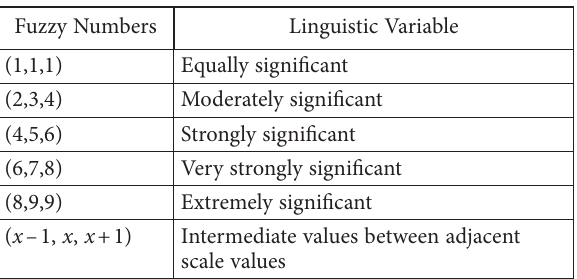
Table 2. The definition of fuzzy quantities (Huang & Peng,